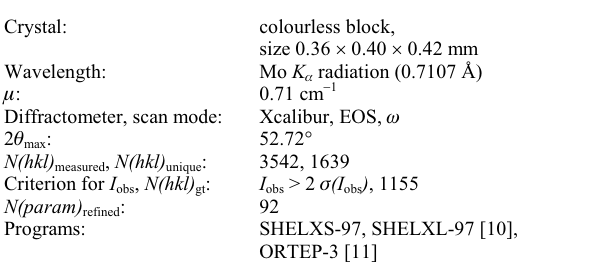
Table 1. Data collection and handling.